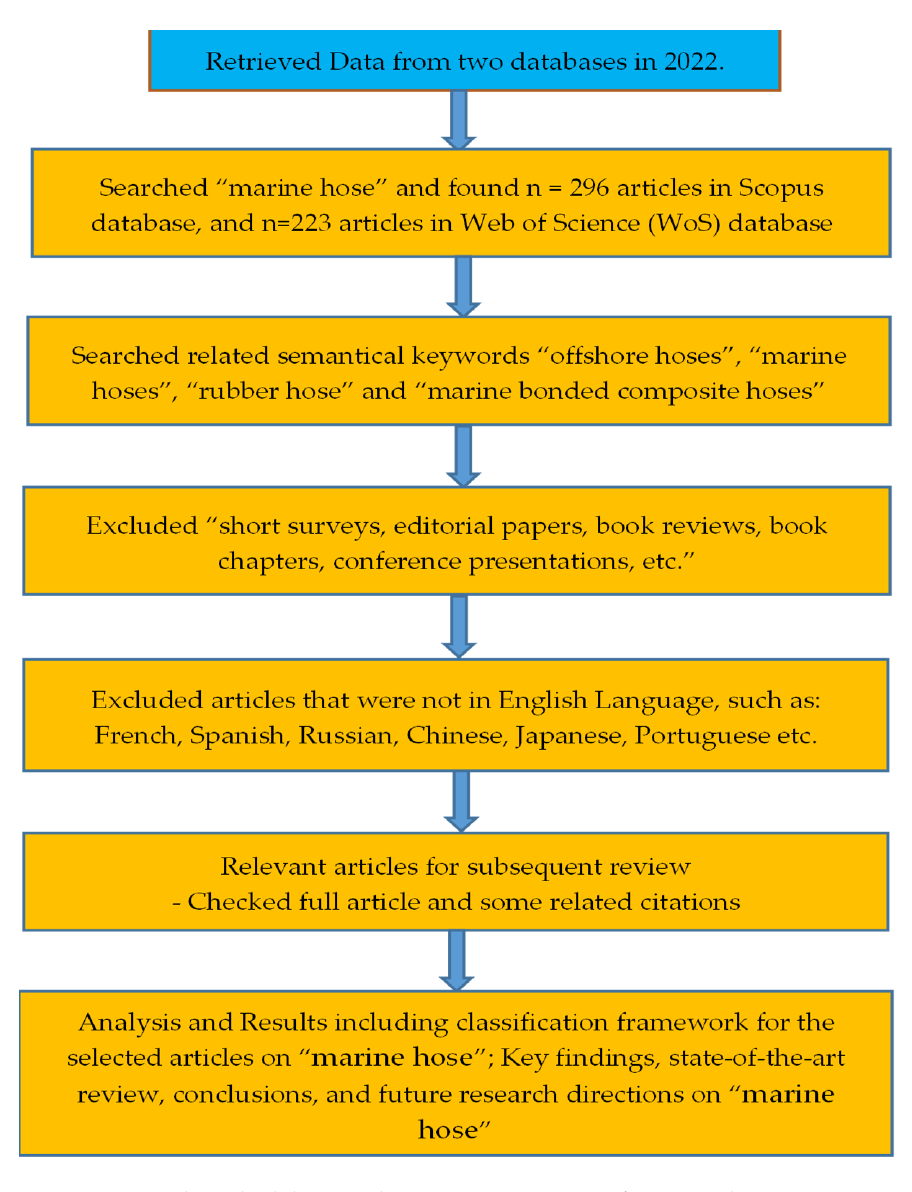
Figure 2. Research methodology on the scientometric review for marine hoses. As indicated in Figure 2, the approach taken into account in the meta-analysis involved using an accessible academic database to extract data on the subject matter and exclude the resources that were not required. It responds to the question, “What are the trends in the research on marine hoses?” What collaborations have been established for marine